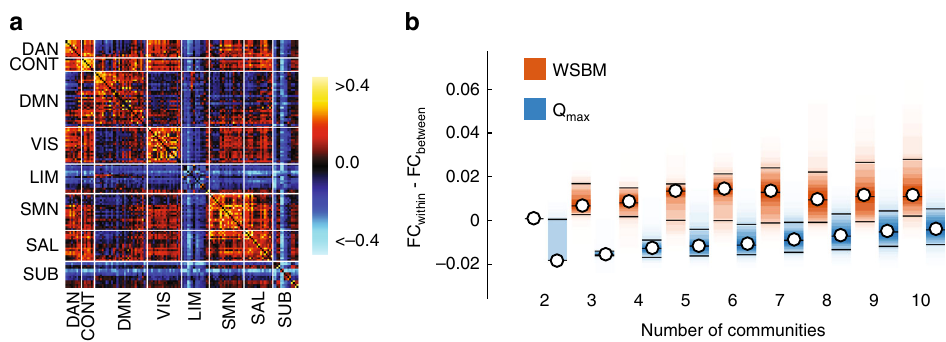
Fig. 5 Communities estimated from the weighted stochastic block model are more functionally segregated than communities estimated from modularity maximization. a Functional connectivity (FC) matrix ordered by functional system: DAN, dorsal attention; CONT, cognitive control; DMN, default mode; VIS, visual; LIM, limbic; SMN, somatomotor; SAL, salience; SUB, subcortical. Note that the order of nodes shown in this panel does not correspond to partitions generated by either the WSBM or Q max . b Difference between within-community and between-community FC for the WSBM (orange) and Q max (blue). Each box plot depicts the variance over partitions detected using either the WSBM or Q